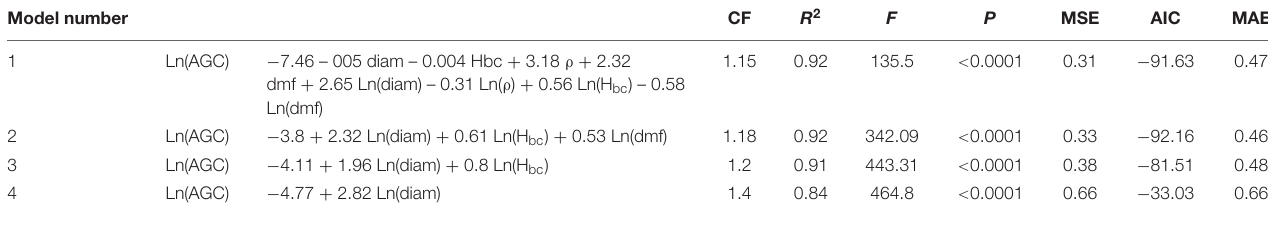
TABLE 3 | General allometric models to estimate above-ground carbon content (AGC; kg) based on seven species of neotropical palms. Model number